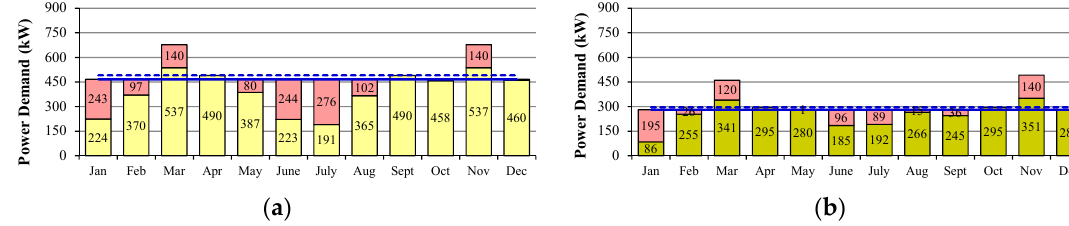
Figure 6. Demand values for ( a ) off-peak scenario 3, and ( b ) on-peak scenarios 2 and 3.